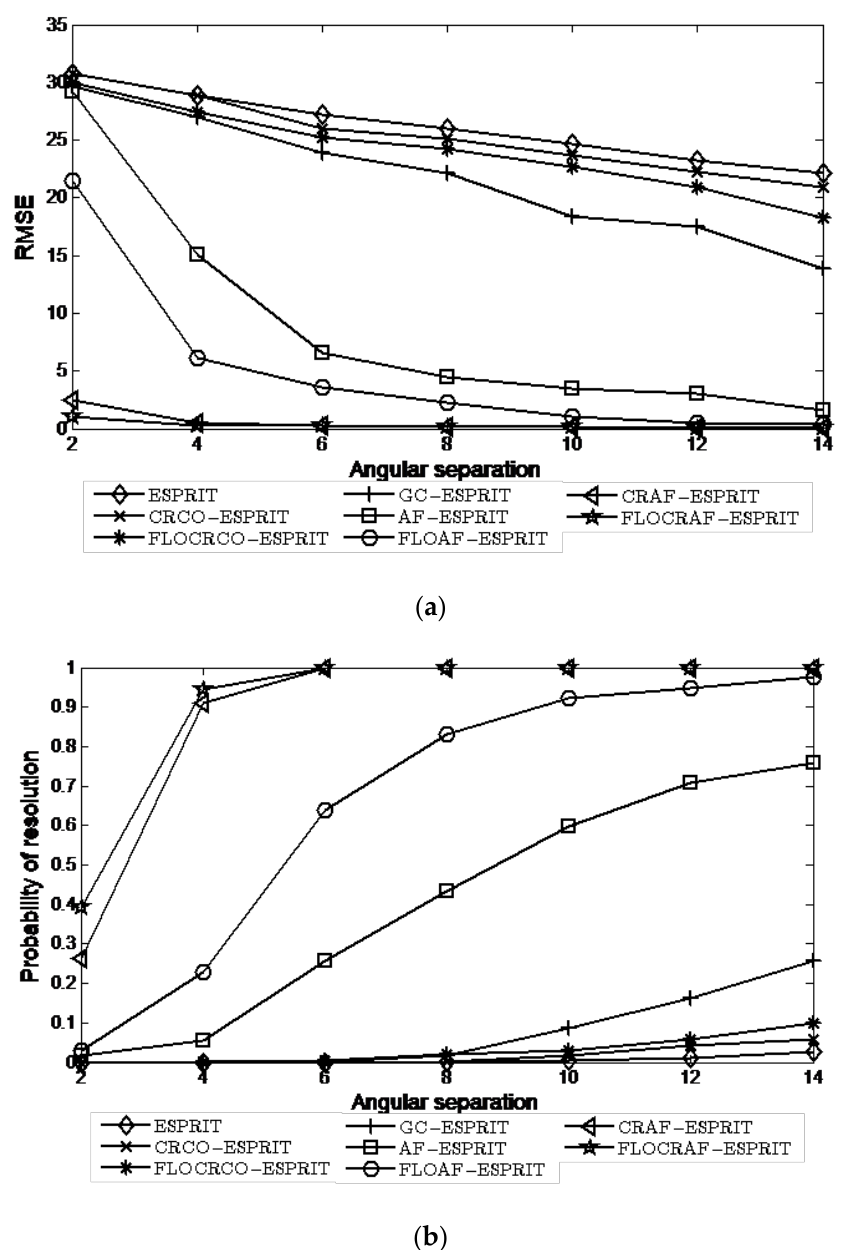
Figure 7. Performance vs angular separation: ( a ) RMSE; ( b ) Probability of resolution.